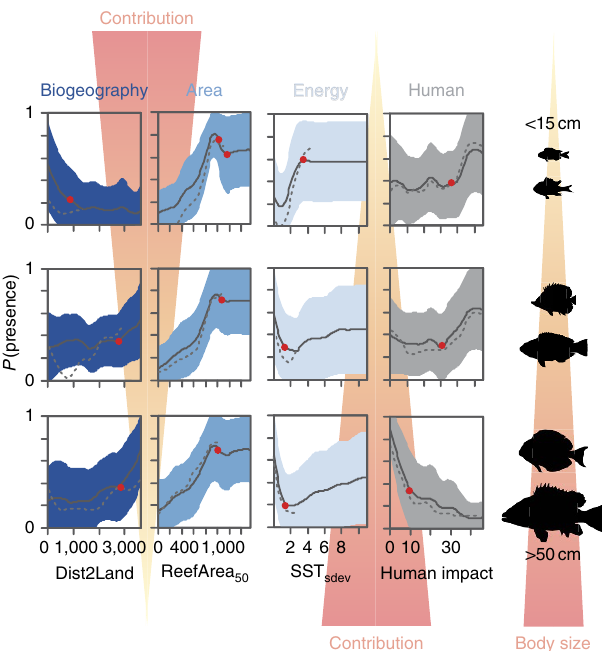
Figure 2 | Predicted probability of occurrence and associated thresholds for species of increasing body size in response to biogeography, energy, area-related correlates and human impact. Only the relationships with the strongest correlates in each category are shown, with Dist2Land : distance to nearest land mass, in km; ReefArea 50 : reef area, in km 2 ; SST sdev : seasonal deviation (that is, seasonality) in sea surface temperature, in (cid:2) C. For each plot, the continuous line represents the mean effect across species and the envelope indicates the 95% confidence interval. Red dots indicate critical thresholds in the mean effect across species (Davies test, P o 0.05). Dotted lines show the response of small-ranging species (first quartile of geographic range sizes), truncated to represent only the range of values where they occur (up to the 98th percentile). Contribution daggers reflect the change in correlate contribution as body size